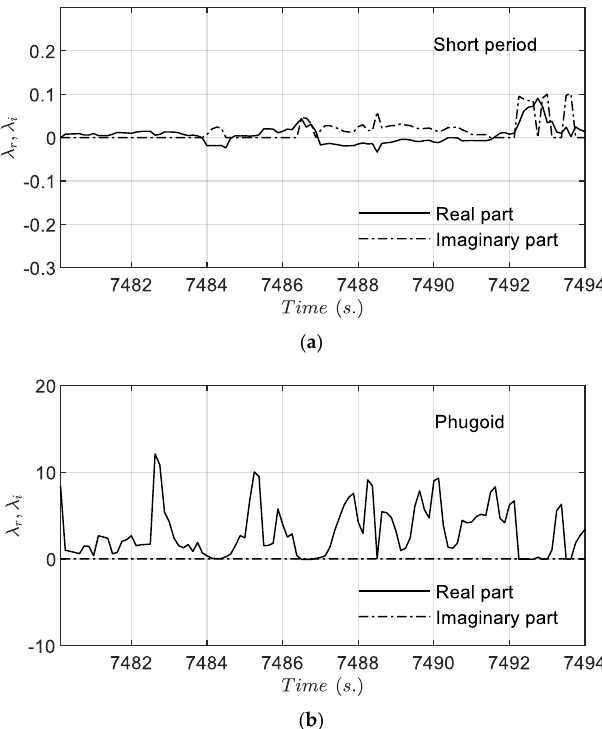
Figure 8. Eigenvalues of longitudinal modes of motion. ( a ) The short-period mode; ( b ) The plunging mode.